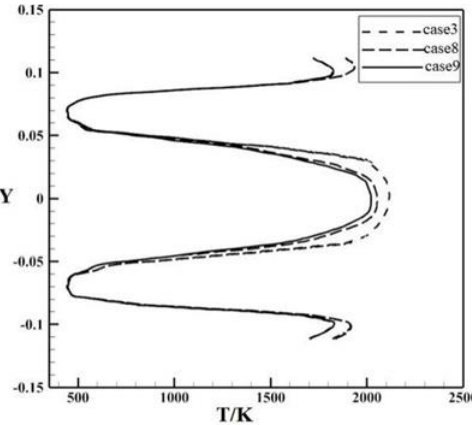
Figure 8. The temperature distribution of the combustor central section at Z/D = 0.05.